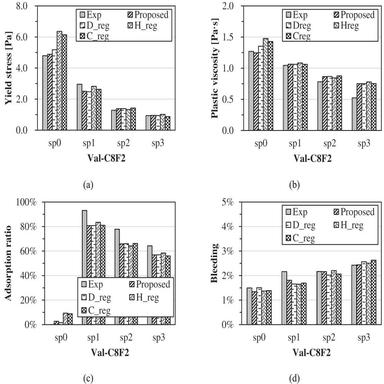
Comparison of experimental results and results from the proposed model and nonlinear regressions: (a) yield stress, (b) plastic viscosity, (c) adsorption ratio, and (d) bleeding (D_reg: diameter-based regression, H_reg: height-based regression, and C_reg: curvature-based regression).